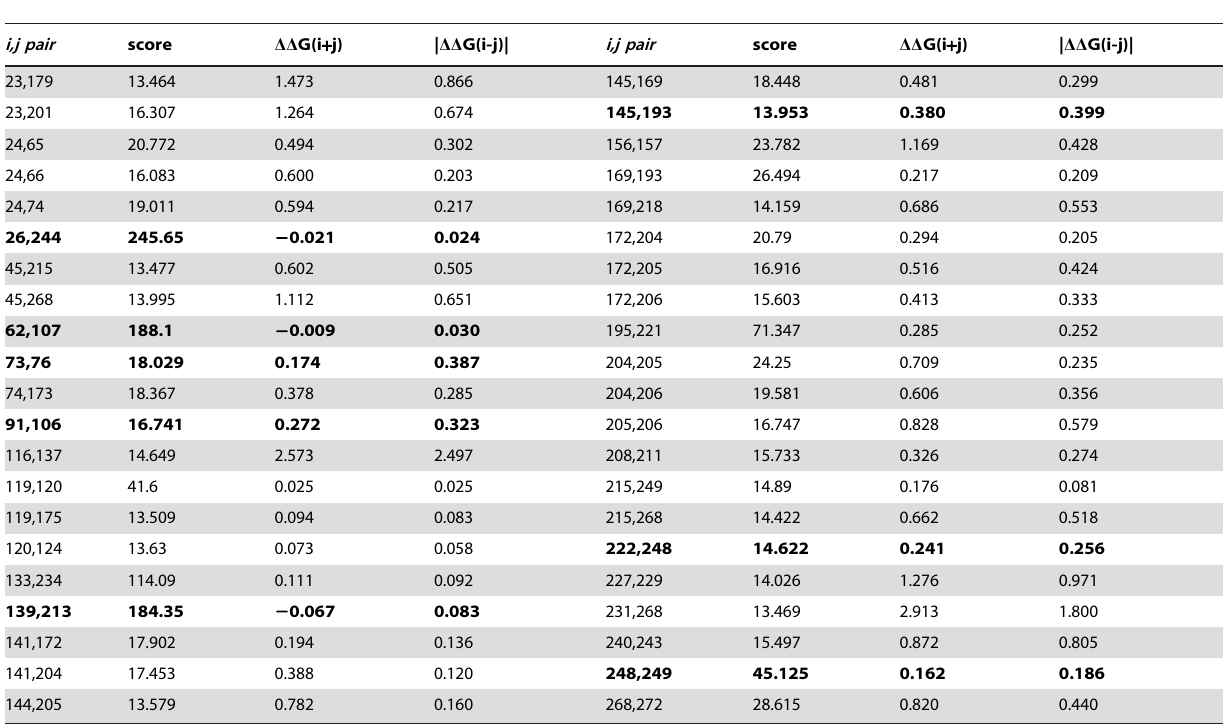
Table 2. Contribution to KDO8PS stability from coevolving pairs with score . 5 s in the ZRes matrix of Figure 3.